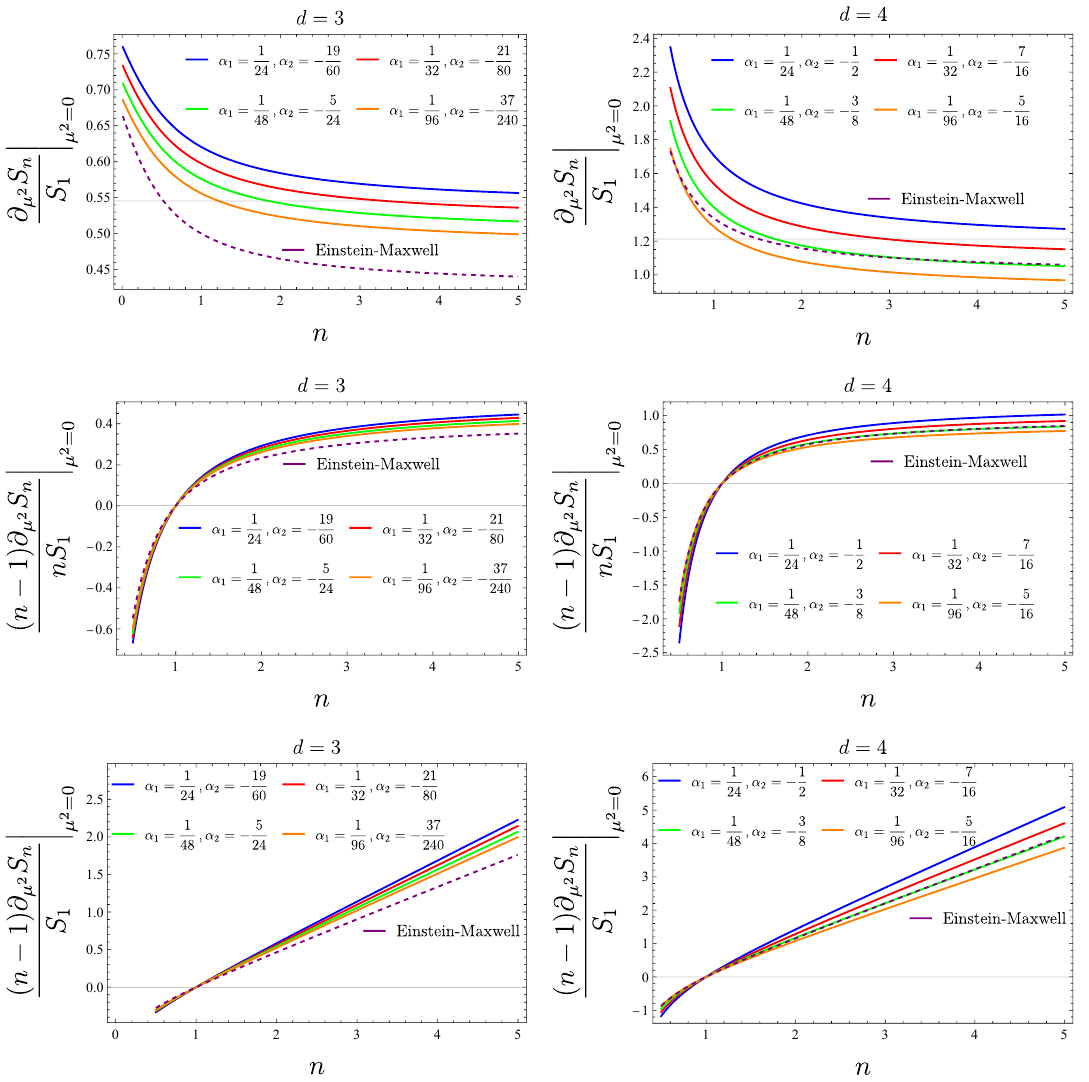
Figure 8. The coefficient of ¯ µ 2 in the Rényi entropies for d = 3 , 4 . We have used different values for the couplings α and α which are compatible with unitarity and the WGC. Remarkably enough, 1 2 we find that all inequalities (8.38) are